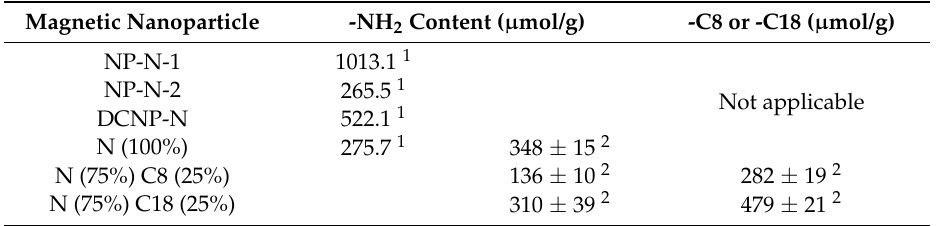
Table 1. Content of amino and hydrophobic (octyl or octadecyl) groups in the magnetic nanoparticles supplied by Koop Technologies (S ã o Carlos, SP,